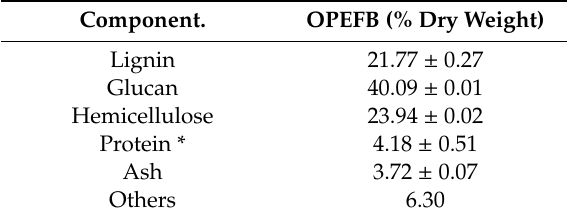
Table 1. Composition of oil palm empty palm fruit bunch